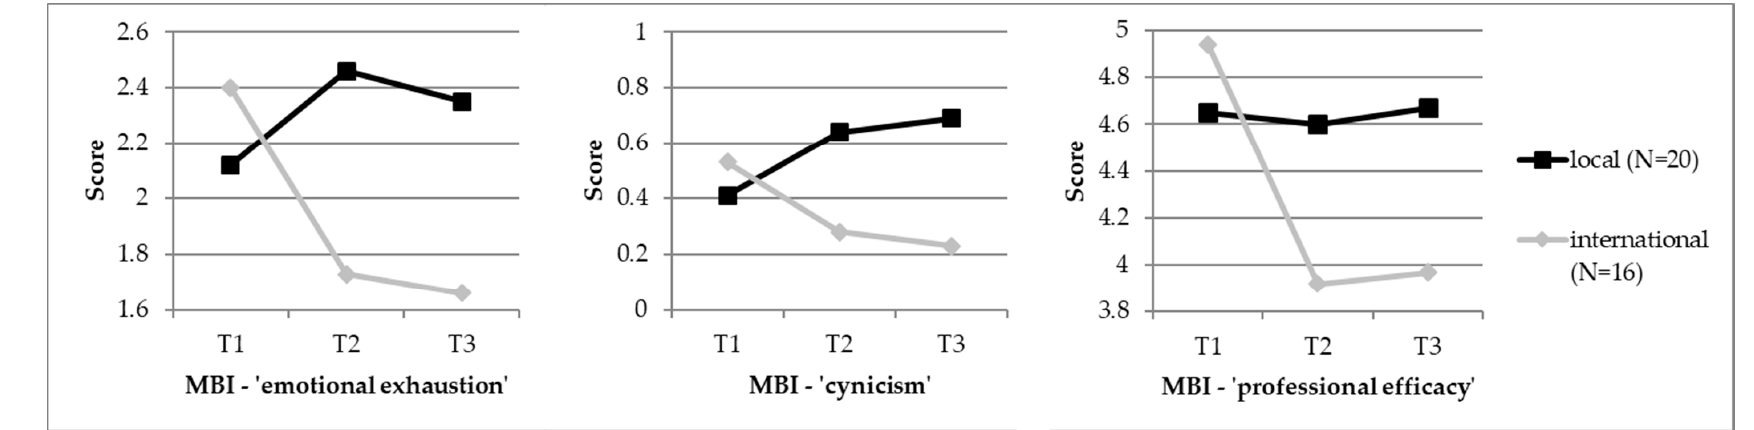
Figure 1. Line charts depicting differences between international and local students concerning the three MBI factors ‘emotional exhaustion’, ‘cynicism’, and ‘professional efficacy’.